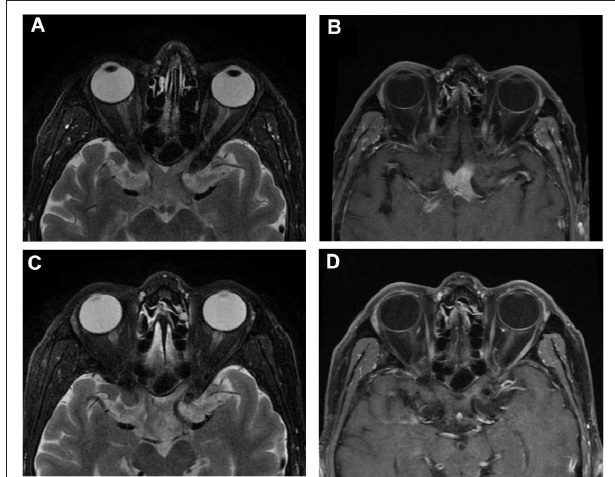
FIGURE 1 | Orbital MRI of Case 1. (A,B) Orbital MRI showed chiasm enlargement in T2-weight imaging and its intrinsic homogenous enhancement of the optic chiasm in T1-weight enhanced imaging when the patient first visited the clinic. (C,D) MRI showed moderate enlargement in T2-weight imaging with a light intrinsic enhancement in T1-weight imaging of the optic chiasm after steroid treatment.